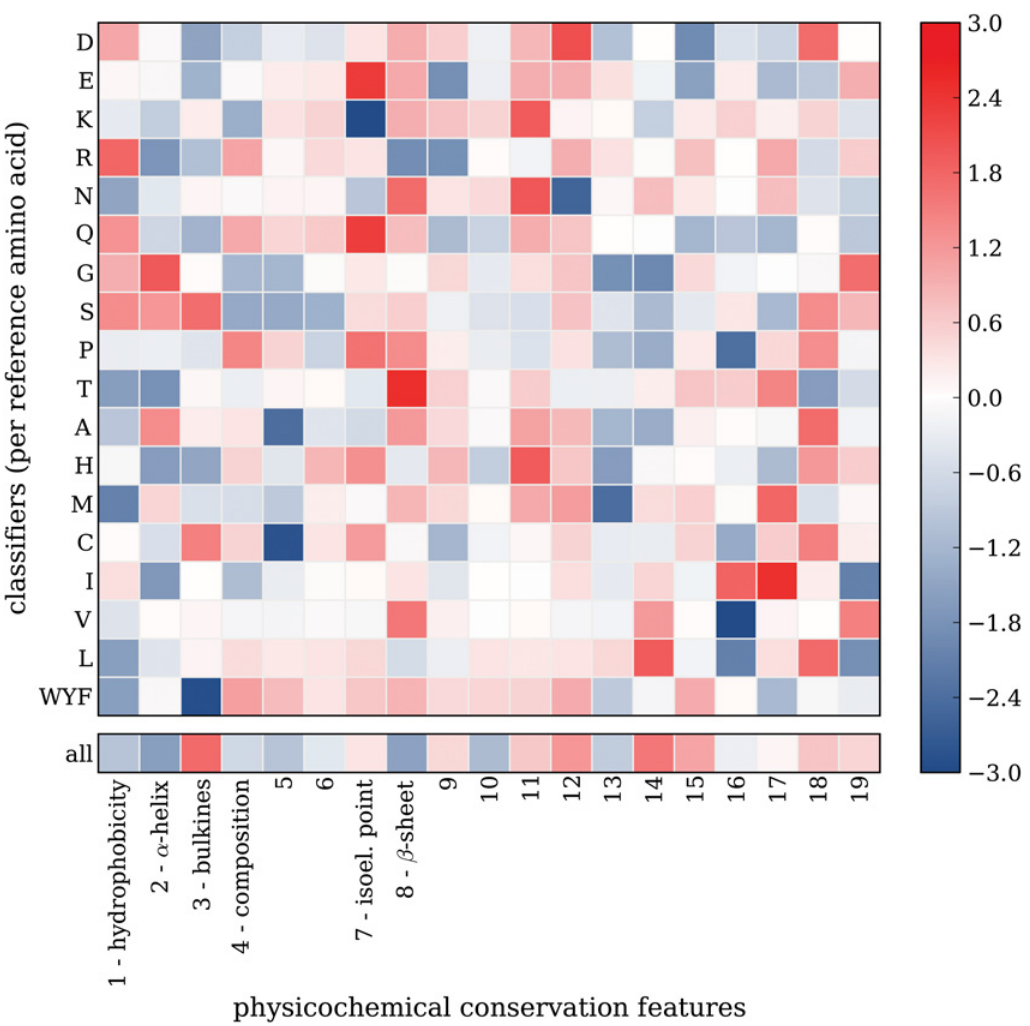
Fig 5. Physicochemical conservation feature weights. Heat maps showing feature weights obtained from classifiers trained using the physicochemical conservation features. The rows show feature weights obtained per subset classifier. The single row at the bottom shows feature weights obtained from a classifier trained on the entire set of variants. Low (blue) and high (red) weights indicate that the feature is predictive for neutral and disease-associated variants